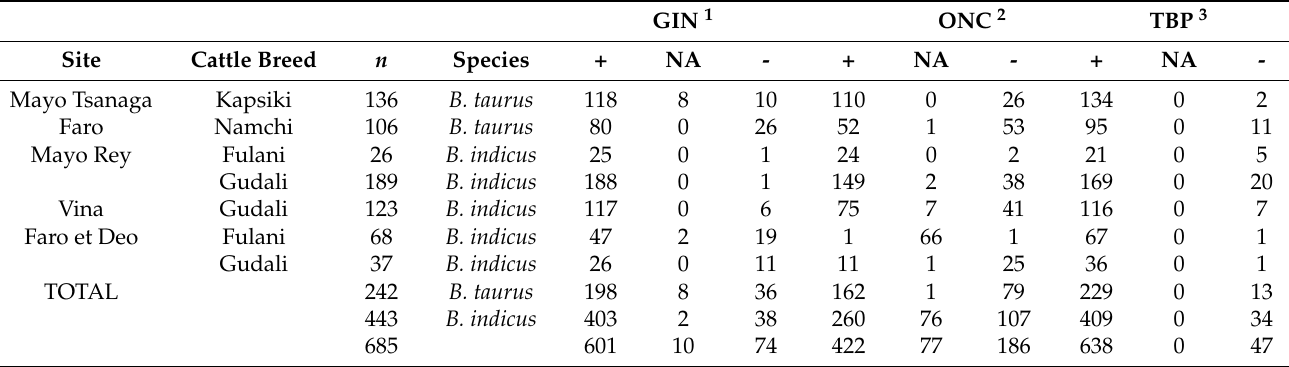
Table 1. Characteristics of phenotyped and genotyped dataset used in the analysis, including the sampling site and parasite burden.